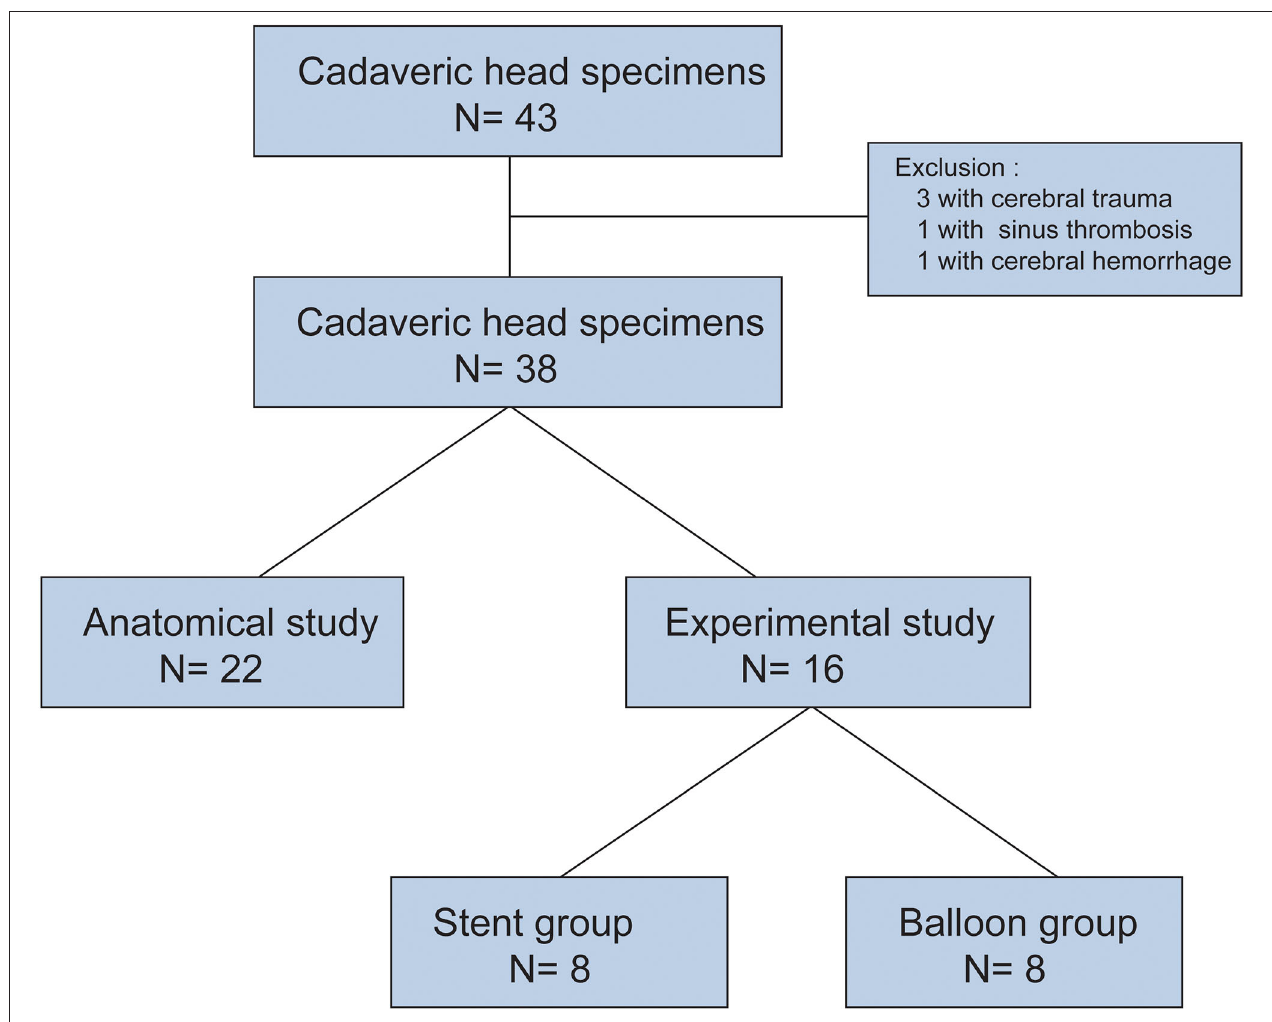
FIGURE 2 | STROBE flowchart of cadaveric heads